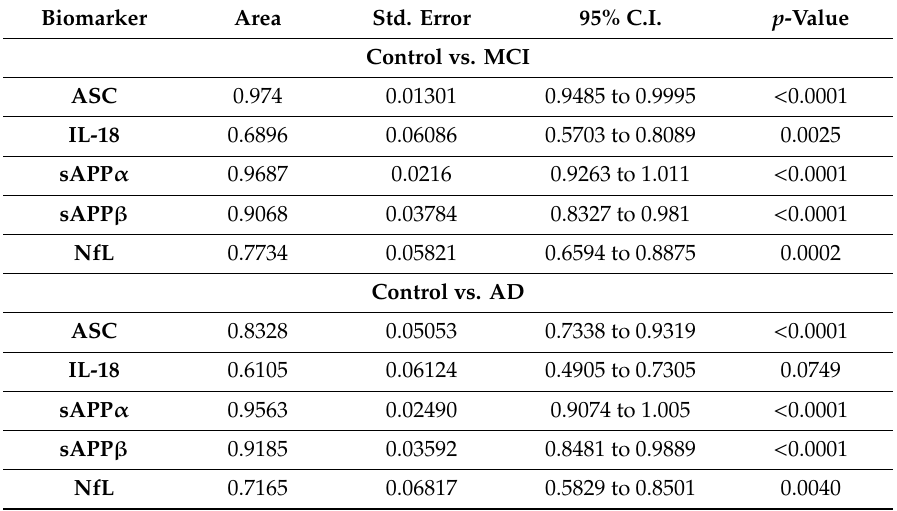
Table 1. Area under the curve. MCI: mild cognitive impairment, AD: Alzheimer’s disease, IL: interleukin, sAPP: soluble amyloid precursor proteins and NfL: neurofilament light.